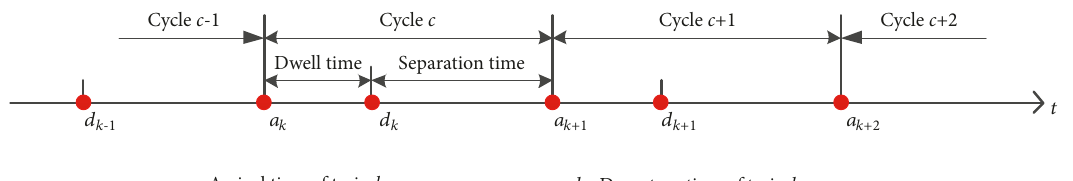
Figure 1: The diagram of a